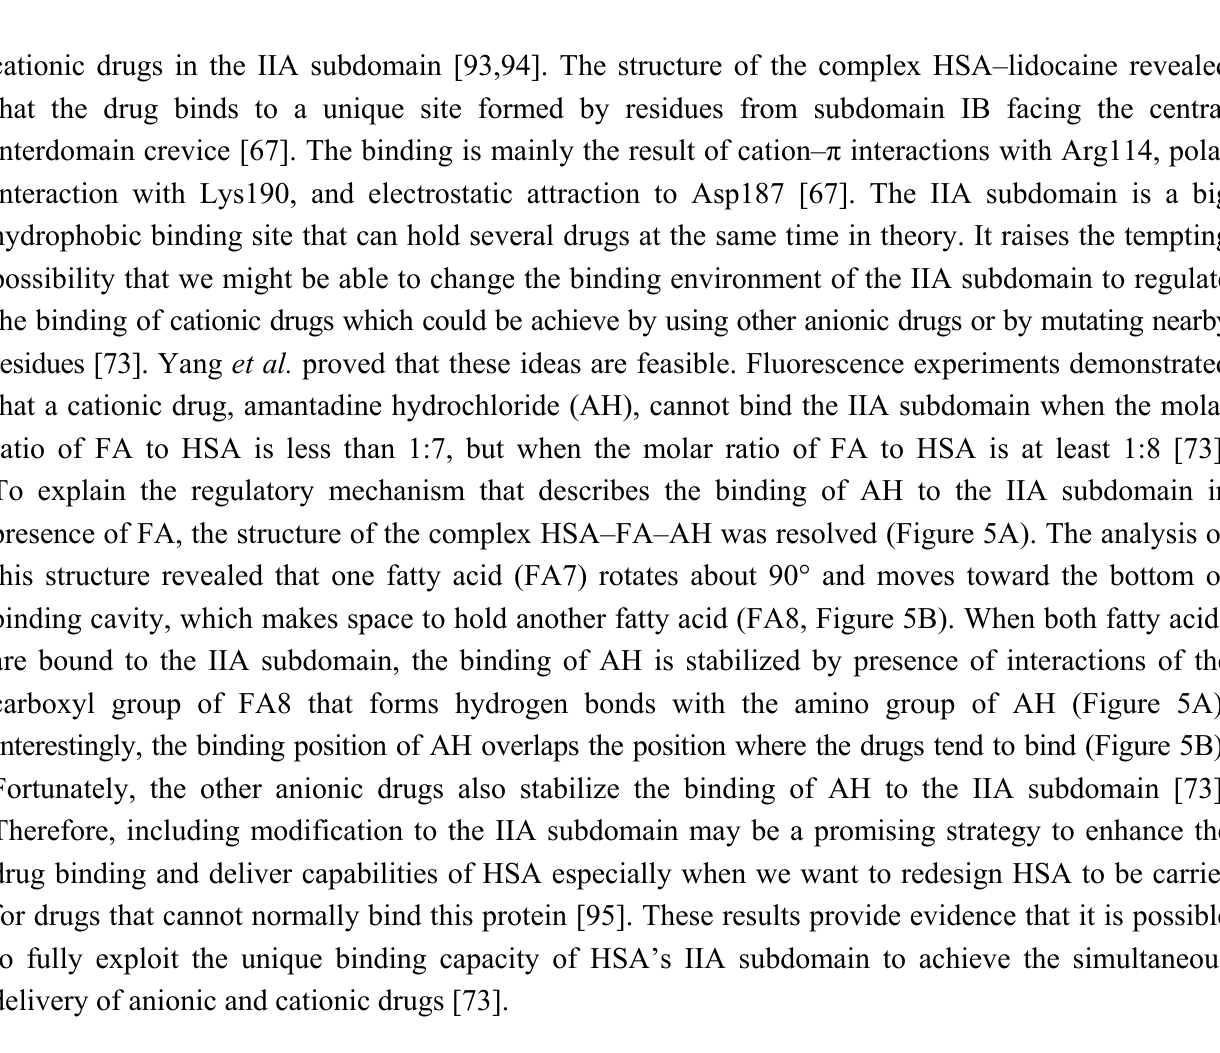
Figure 5. ( A ) Structural basis of AH and two FAs co-binding to subdomain IIA of HAS; ( B ) Binding mechanism of AH regulated by two FAs in IIA subdomain of HAS. Dashed line (red), hydrogen